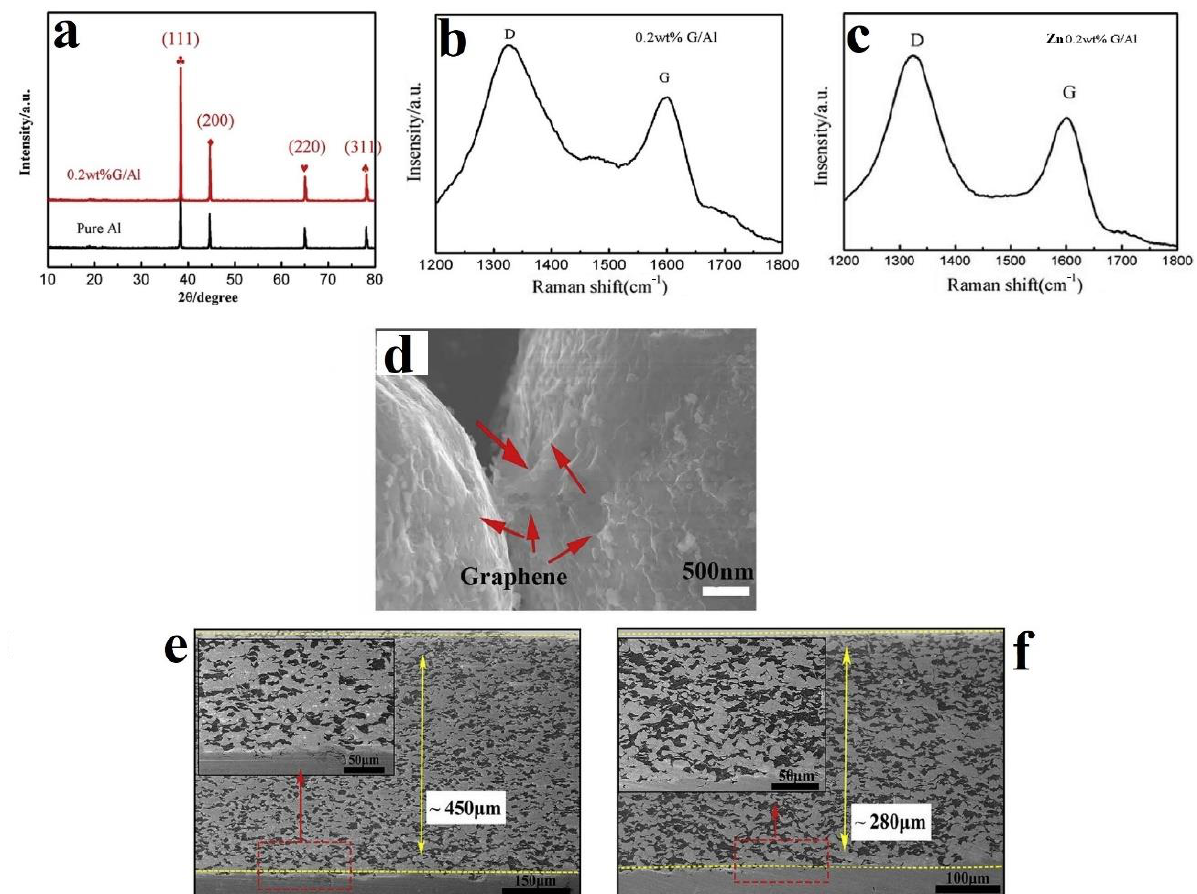
Figure 5. ( a ) XRD patterns of pure Al and GNP/Al powders, ( b ) Raman spectrum of GNP/Al powder, ( c ) Raman spectrum of Zn/0.2% GNP/Al CS coating, ( d ) SEM of GNP/Al powder, ( e ) SEM image of Zn/Al CS coating, ( f ) SEM image of Zn/0.2% GNP/Al CS coating. Presented with permission from [67].